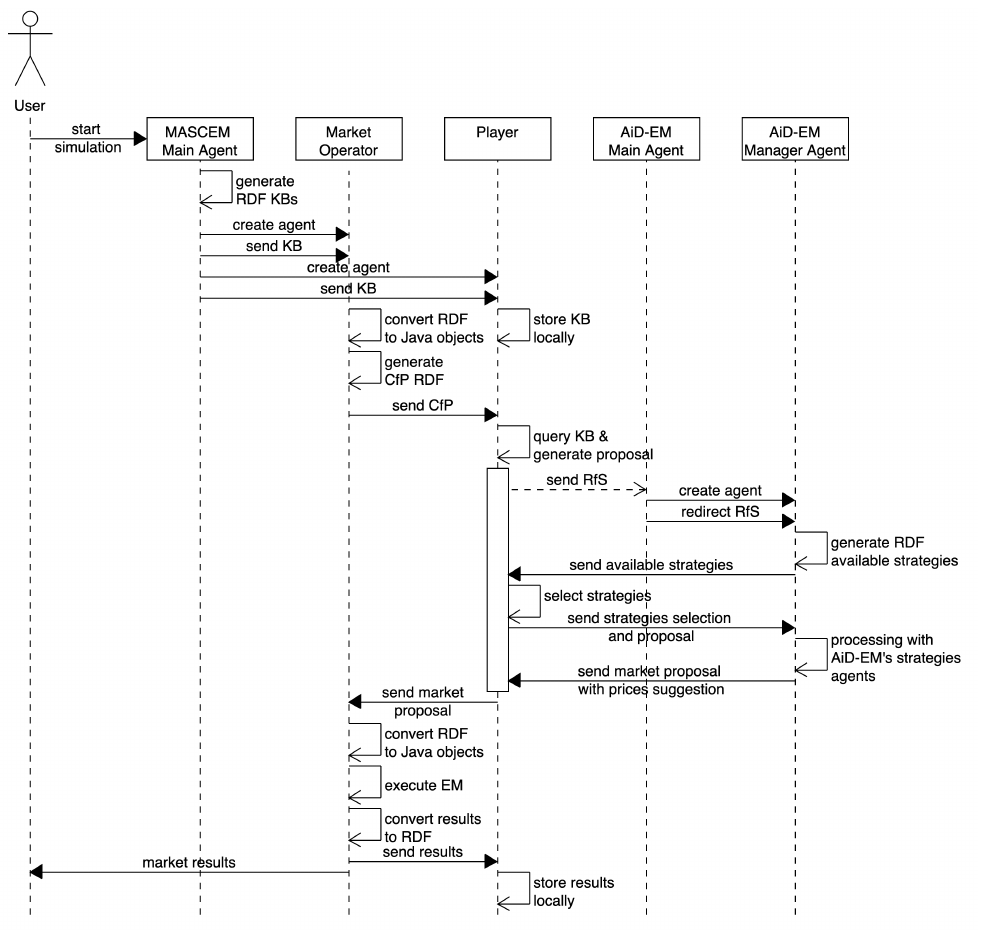
Figure 4. Communications exchanged using the developed ontologies